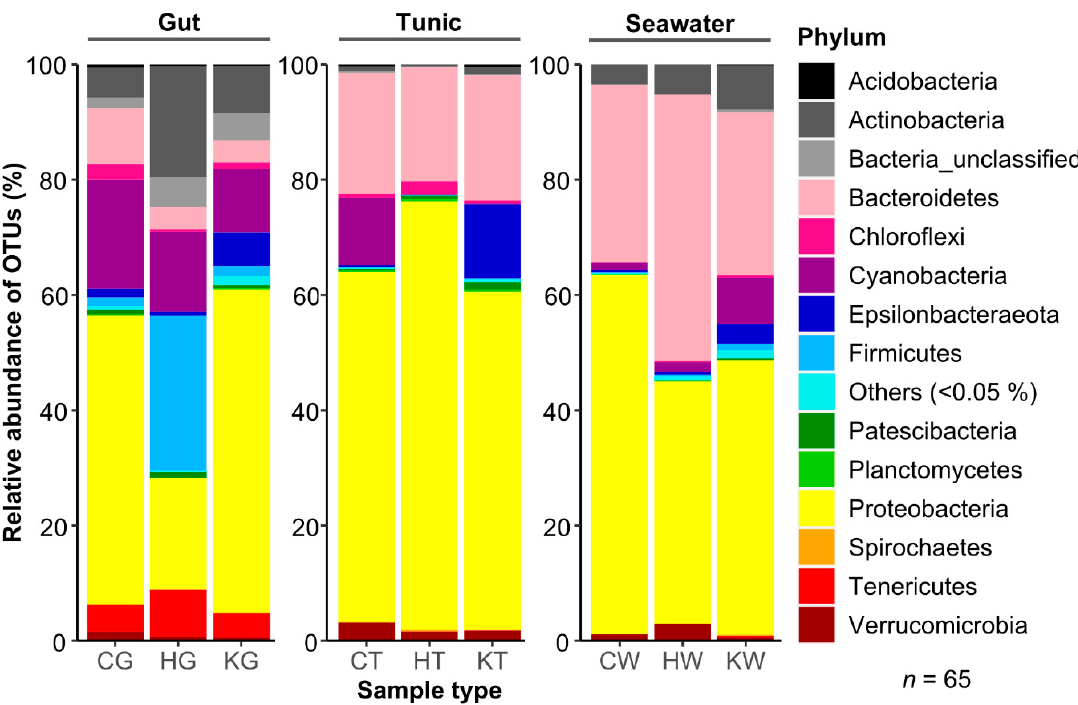
Figure 1. Comparative microbiome analysis of three C. intestinalis populations. The taxonomic assignment was conducted with SILVA (release 132) and is shown on the phylum level. Replicates were combined by calculating the median relative abundance for each phylum. Samples were abbreviated with a letter for the respective sampling site (Canada, C; Helgoland, H; Kiel, K) and sample type (gut, G; tunic, T; seawater, W).